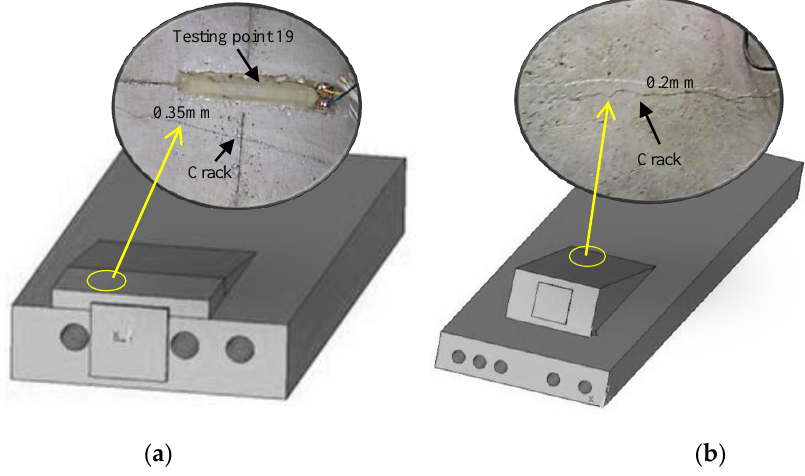
Figure 14. Distribution of the cracking: ( a ) The top slab; ( b ) The bottom slab.